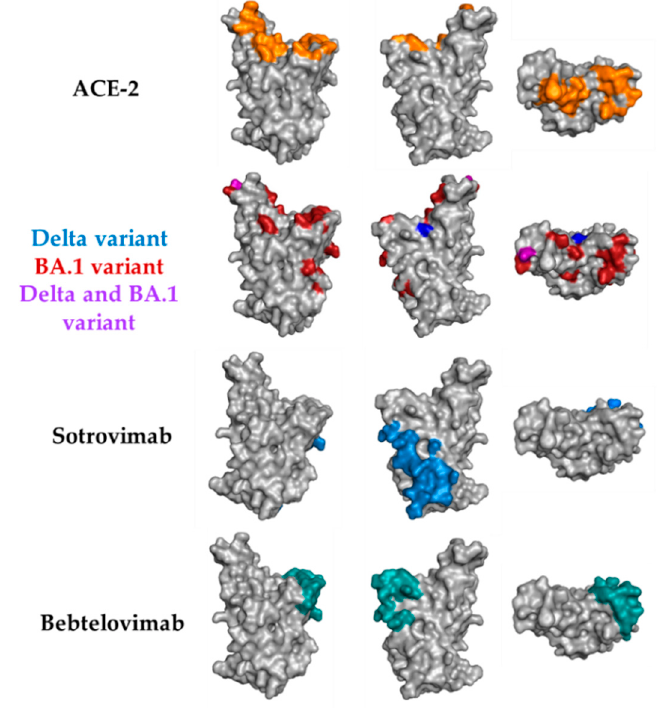
Figure 6. Connolly surface of the RBD side and top views mapping the residues involved in the interaction with hACE2 (top), mutations of the Delta and Omicron (BA.1) variants with respect to the RBD WT and epitopes of sotrovimab and bebtelovimab. The figures were generated with PyMOL Molecular Graphics System version 2.4.1 using the PDB ID: 6VW1 for the RBD:hACE2 interface and mutations of Delta and Omicron, PDB ID: 7SOC for the epitope of sotrovimab and PDB ID: 7MMO for the epitope of